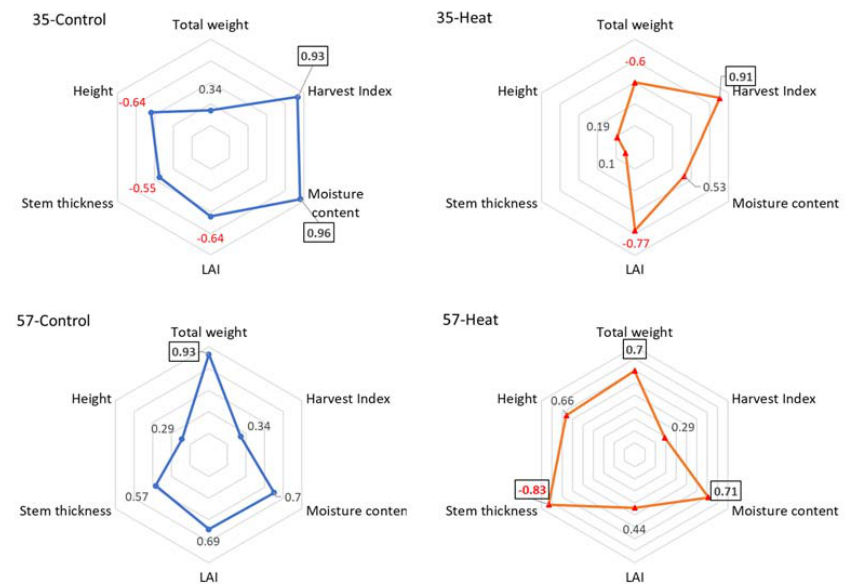
Figure 3. Correlation spider charts for showing correlation between fresh fruit weight and other morphological characteristics, including total weight, harvest index, moisture content, leaf area index (LAI), stem thickness, and plant height of all accessions treated with heat (orange line) for 35 days and 57 days and grown in control conditions (blue line). Red number indicates the negative relationship between accessions. Numbers in black box indicate significant correlation at alpha = 0.05.